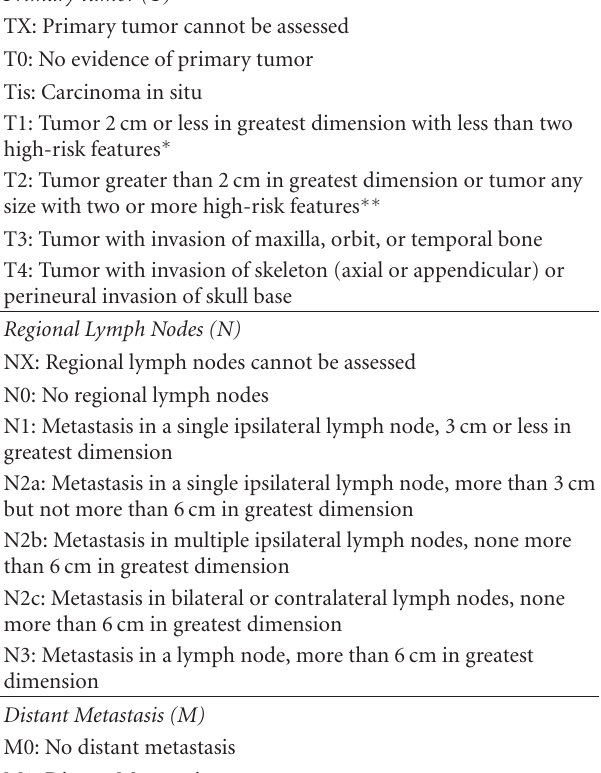
Table 1: Characteristics of high-risk tumors. Adapted from NCCN Practice Guidelines in Oncology: Basal Cell and Squamous Cell Skin Cancers [36].